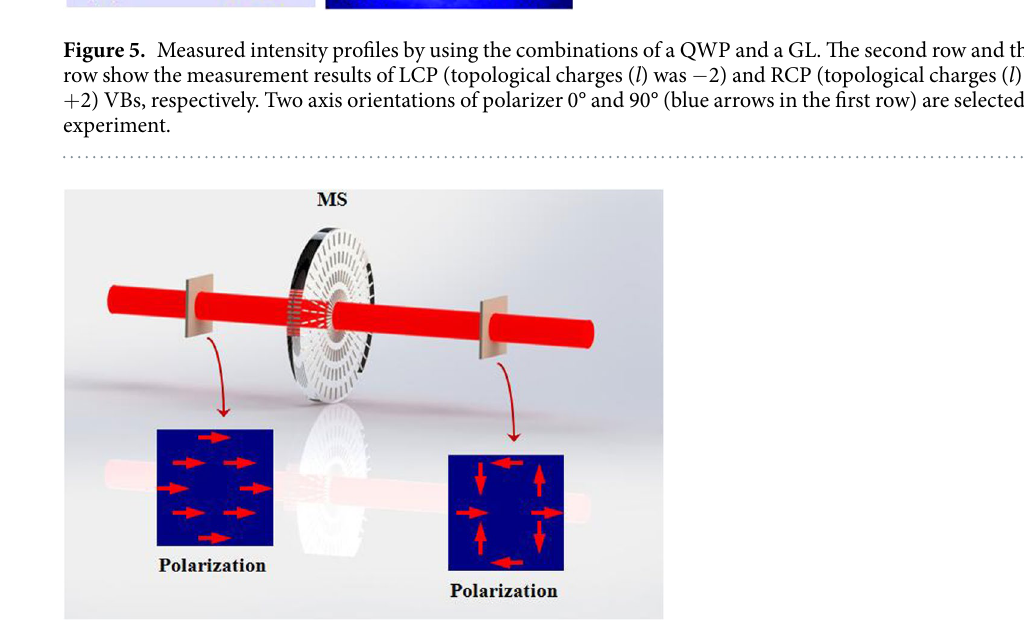
Figure 6. The conventional optical system applied to generate CVB. A horizontal (vertical) linear polarized light beam can be used to generate radial (azimuthal) CVB by using metasurface. Insets show the polarization patterns in each step of this